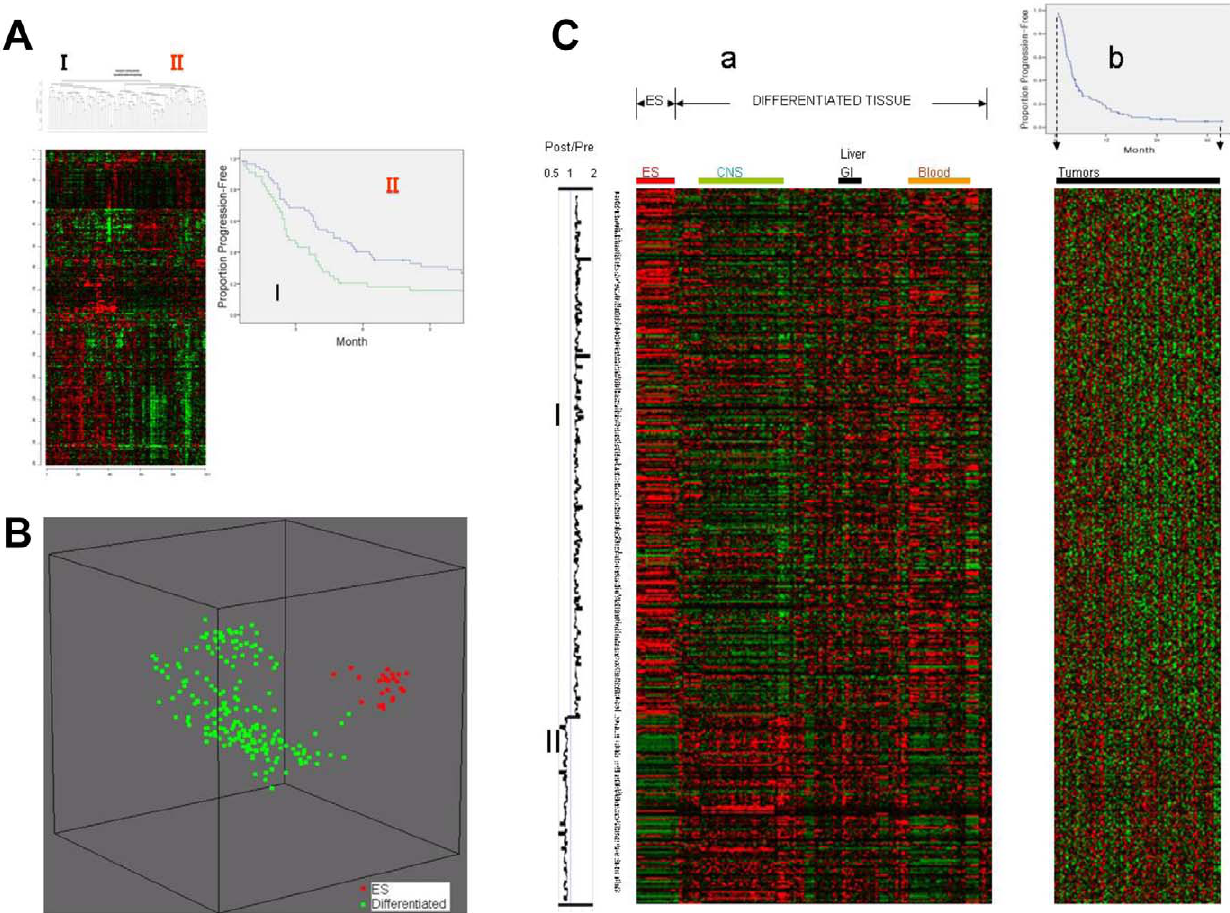
Figure 2. Acquired resistance signature and stem cell signature. (A) Hierarchical clustering of 101 pretreatment patient samples using the ‘‘ES set without proliferation genes signature’’. Kaplan-Meier plots for time to progression (TTP) of patients in each cluster generated are shown on the right side. Patients in high risk cluster (I) (n=44, high expression of ‘‘ES set without proliferation genes’’) had a significantly shorter TTP than patients in the low risk cluster (II) (n=57, low expression) (2.7 vs. 4.7 months; Log-rank P value=0.014). (B) Principal component analysis plot using a published U133A microarray meta-analysis dataset [14] containing 24 human ES cell samples ( shown in red ) and 193 various fetal and adult differentiated tissue samples ( shown in green ) using the 633-gene acquired resistance signature (feature selection P , 0.01). Each sphere represents a single sample. Samples whose expression profiles of 633 genes are similar are shown close together. (C) a . Expression of the 633-gene acquired resistance signature using the same published meta-analysis microarray data 14 as in (B). Heatmap generated using a log 2 -pseudocolor image with gene centering. Red and green colors represent high and low gene expression levels, respectively. Genes upregulated at the chemoresistant state of our study patients (post/pre . 1, I) show coordinated overexpression in ES cells ( left ), while genes downregulated at the chemoresistant state (post/pre , 1, II) show coordinated overexpression in differentiated tissue samples ( right ). b . Expression of the same 633-gene acquired resistance signature in 101 pretreatment samples collected from a separate set of gastric cancer patients. Each row represents each patient, sorted according to the increasing order of TTP from left to right, as matched with Kaplan-Meier curves for TTP of 101 patients ( top right ). Genes upregulated at the chemoresistant state of our study patients (I) show the concordant overexpression in patients with shorter TTP ( left ), while genes downregulated at the chemoresistant state (II) show the concordant overexpression in patients with longer TTP ( right ). doi:10.1371/journal.pone.0016694.g002 PLoS ONE |